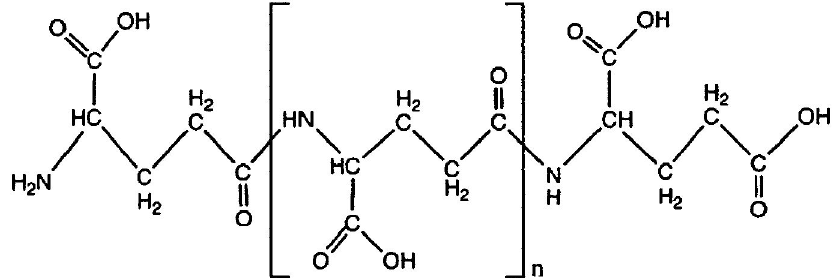
Figure 1. Structure of poly-γ-glutamic acid (PGA).